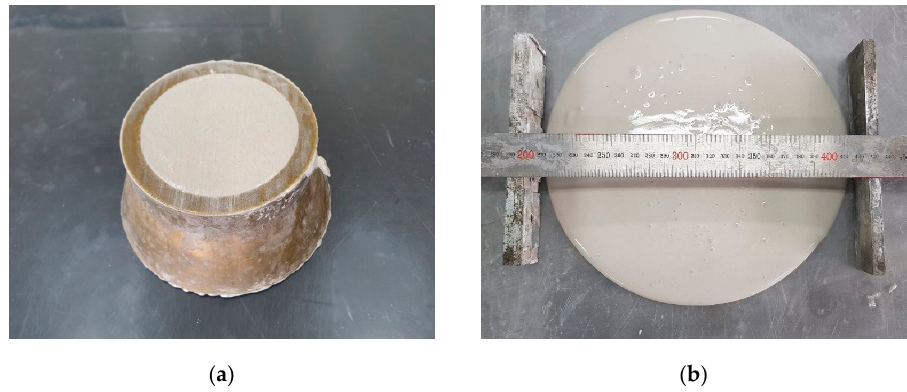
Figure 3. A mini slump test: ( a ) test setup, ( b ) flow measurement of AAS paste.